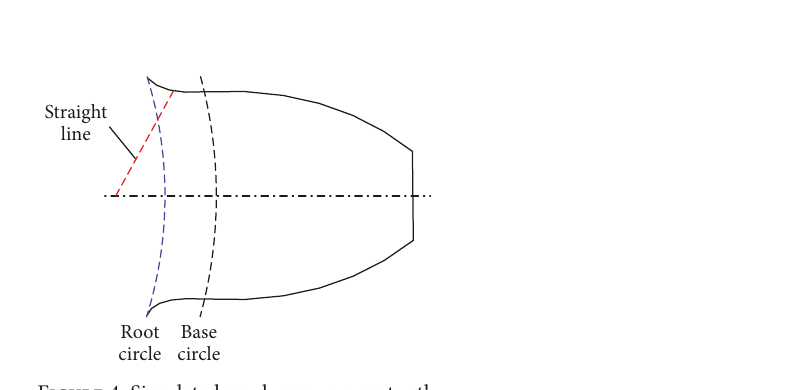
Figure 4: Simulated crack on sun gear